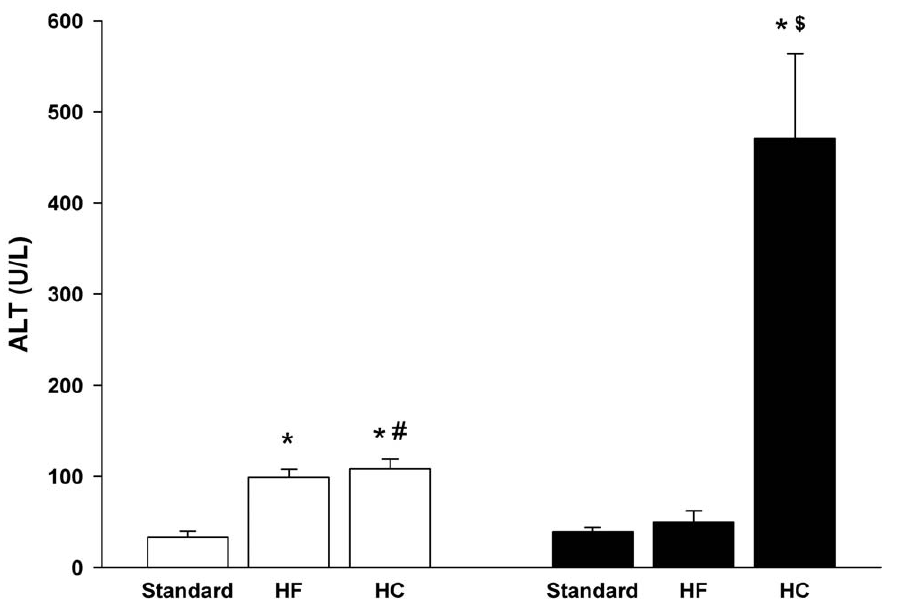
Figure 3. Effect of HF and HC diets on plasma levels of ALT. Values are means 6 SE for n=5 mice in each group. Symbols are defined in Figure 2 legend.